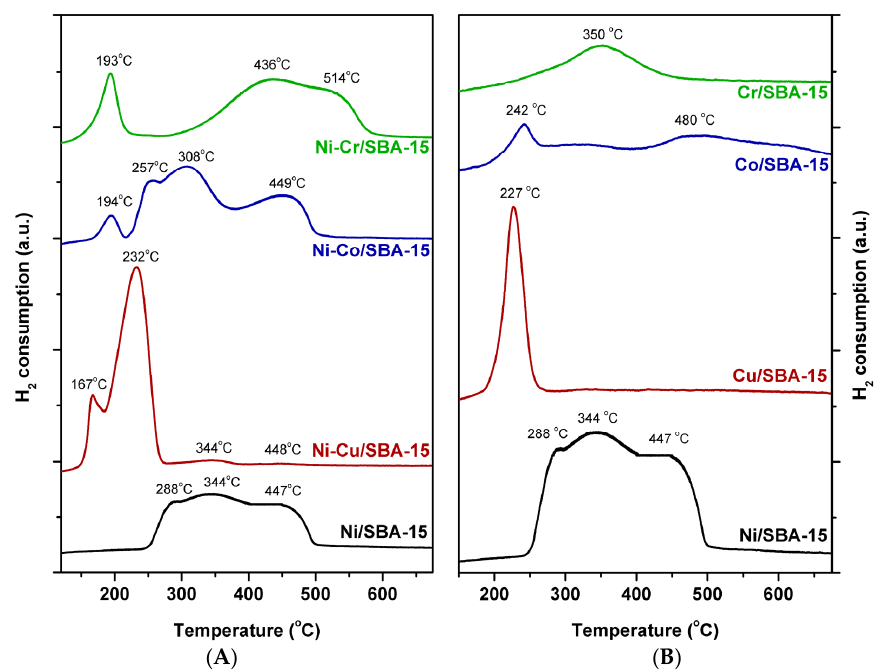
Figure 5. TPR profiles: ( A ) Ni-(Cu,Co,Cr)/SBA-15 catalysts; and ( B ) monometallic samples.